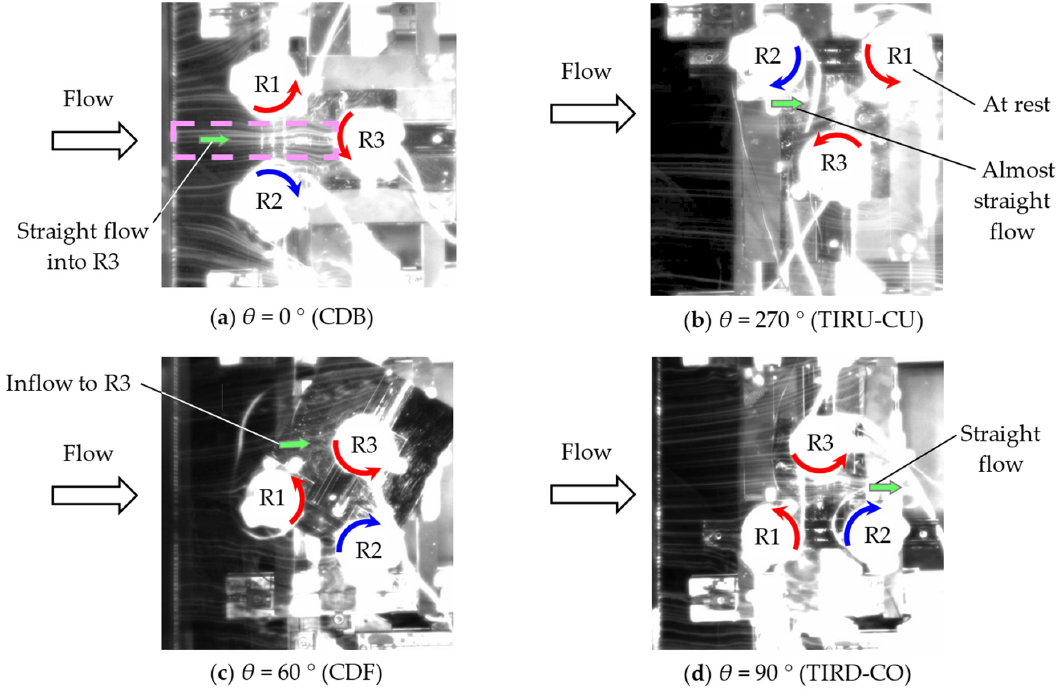
Figure 23. Photographs of smoke flow through three turbines at g / D = 1 under V = 2 m/s in the 3IR configuration: ( a ) θ = 0°; ( b ) θ = 270°; ( c ) θ = 60°; ( d ) θ = 90°.